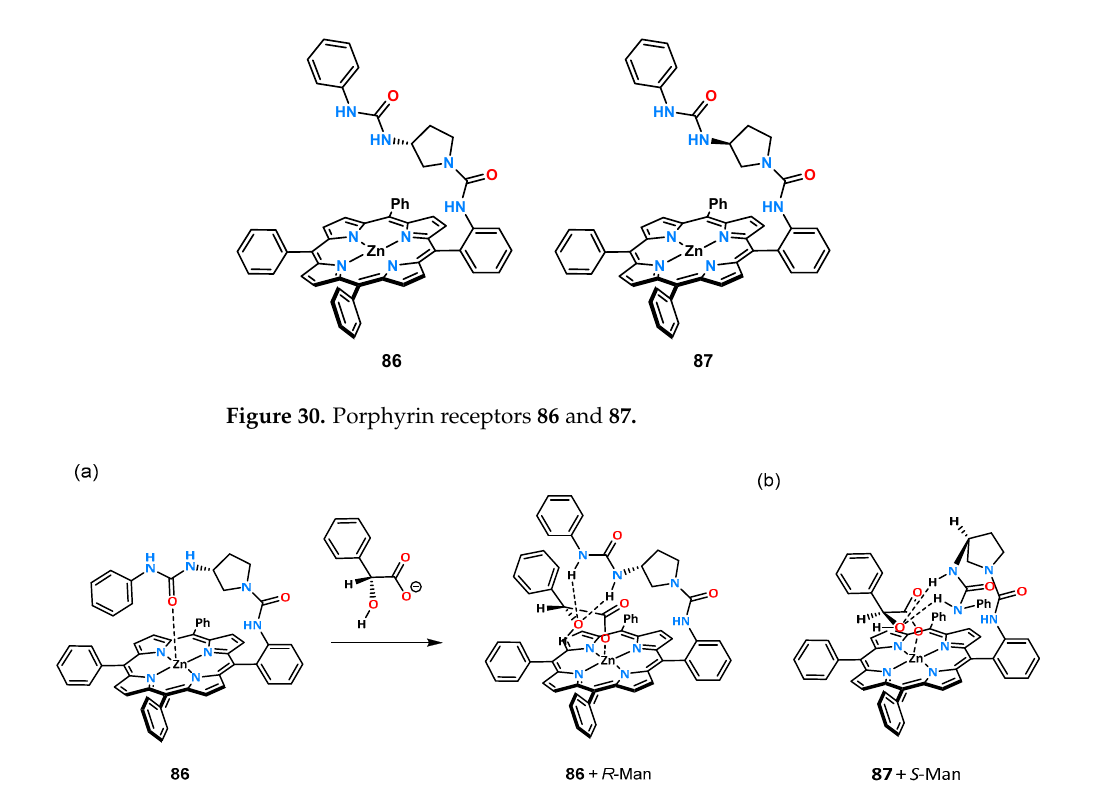
Figure 30. Porphyrin receptors 86 and 87.